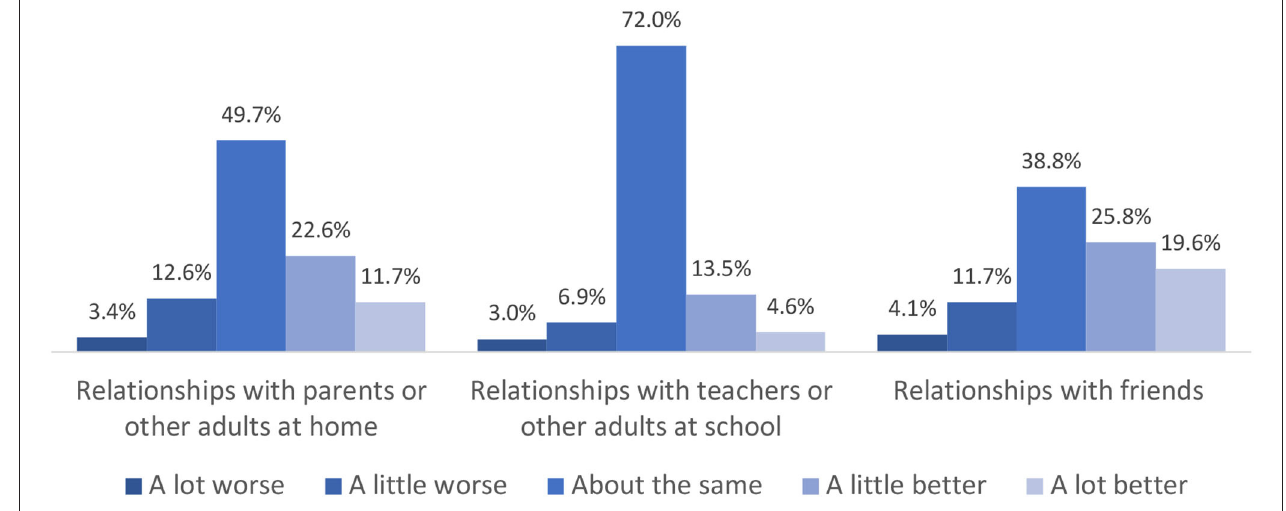
FIGURE 3 | Students’ perceived changes in relationships from before the COVID-19 pandemic to now.